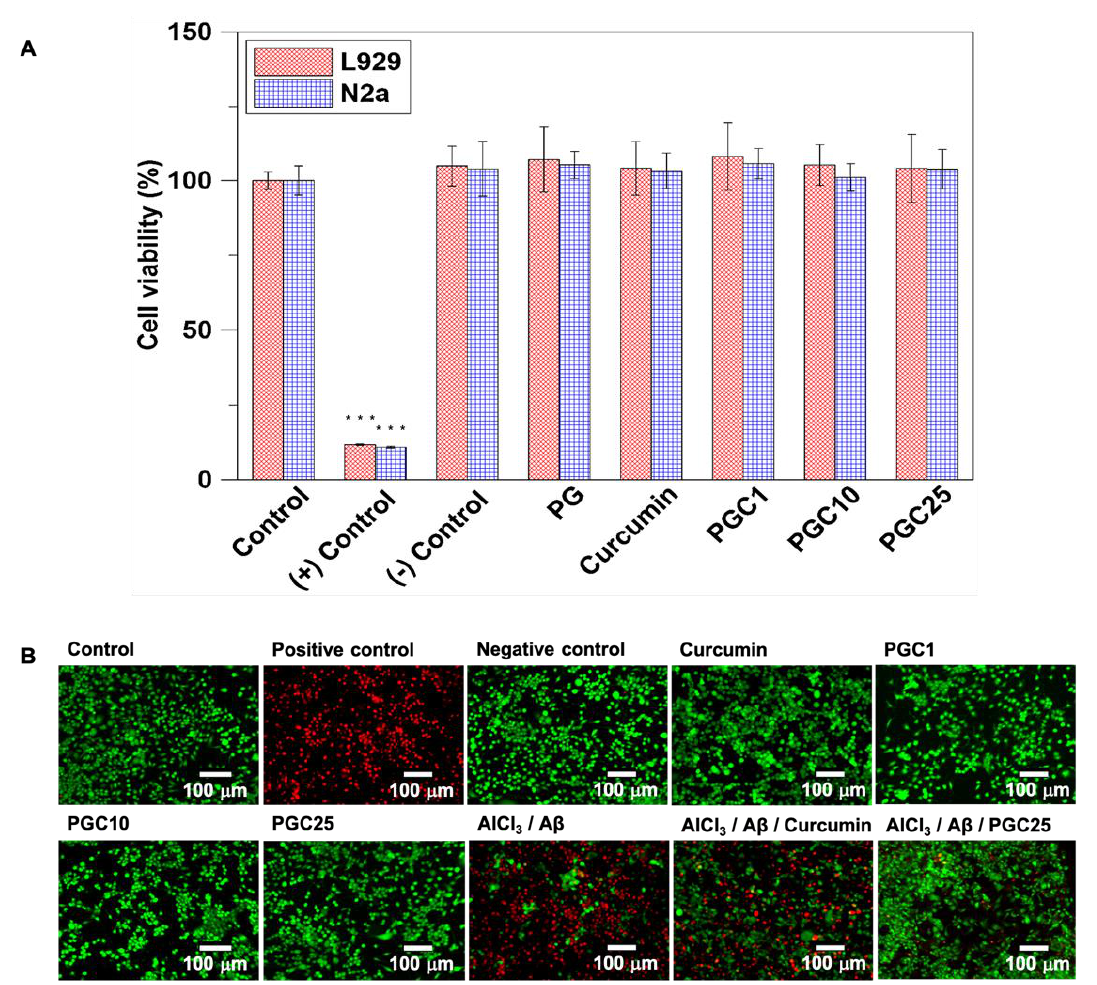
Figure 3. The evaluation of cell viability of thermo-gel and inhibition of A β -induced cytotoxicity. ( A ) The cell viability of PG and PGC by WST-1 ( n = 6, *** p < 0.001 compared with control). ( B ) The LIVE/DEAD staining of N2a cells in the control: cells cultured in medium only; Positive control: cells treated with zinc diethyldithiocarbamate; Negative control: cells treated with aluminum oxide; Curcumin: cells treated with 25 μM curcumin; PGC1: cells treated with PGC1; PGC10: cells treated with PGC10; PGC25: cells treated with PGC25; AlCl 3 /Aβ: cells treated with AlCl 3 and Aβ42; AlCl 3 /Aβ/Curcumin: cells cocultured with AlCl 3 , Aβ42 and 25 μM curcumin; AlCl 3 /Aβ/PGC25: cells cocultured with AlCl 3 , Aβ42 , and PGC25.